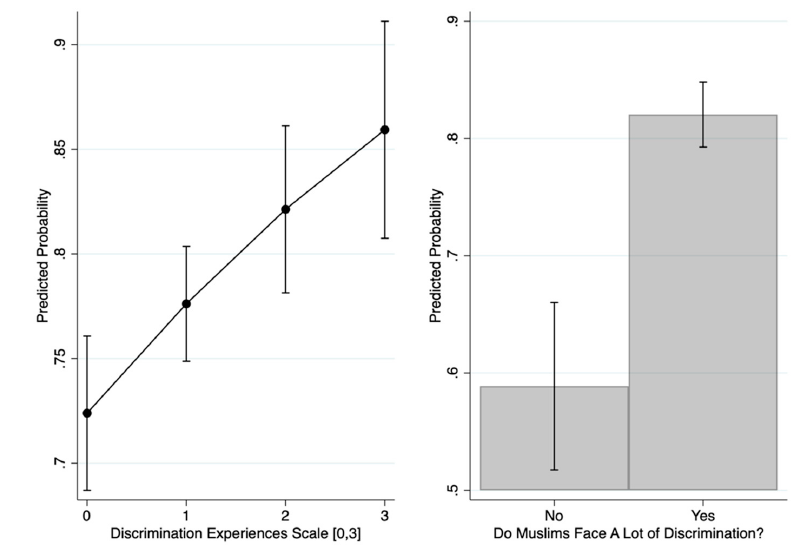
Figure 1. Predicted probability of believing change is still needed to achieve equality for Black people, computed from models 1 (left) and 2 (right) of Table 2, which utilize the 2017 data and include controls for age, gender, ethnicity, generation, income, mosque attendance, frequency of prayer, and political ideology.